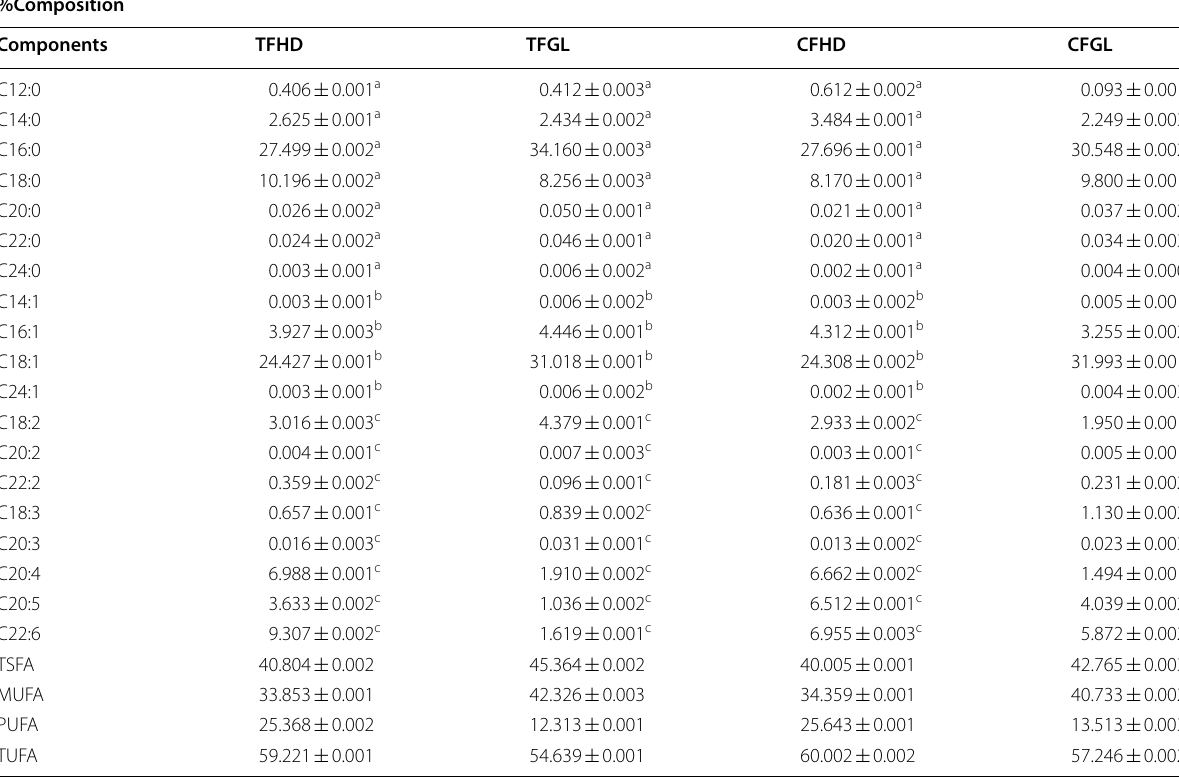
Results expressed as average TFHD Titus fish head; TFGL =